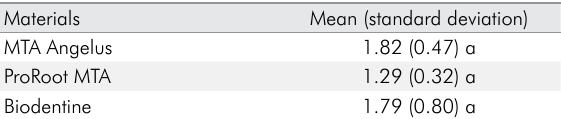
Table 1. Mean and standard deviation of the push-out strength values (in MPa) for the displacement of the retro-end filling materials from the specimens.